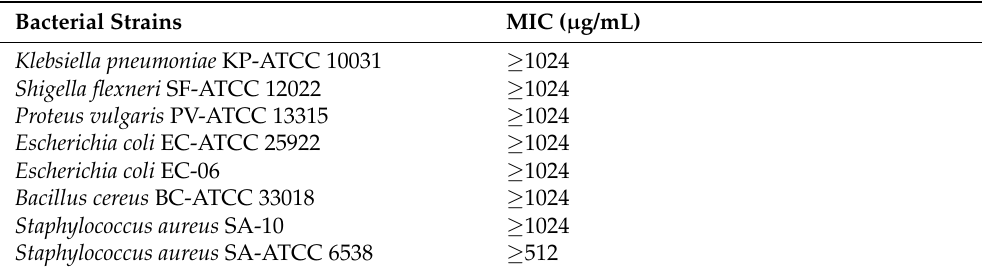
Table 2. Results for the minimum inhibitory concentration—MIC of the fixed oil of the seed of Hancornia speciosa